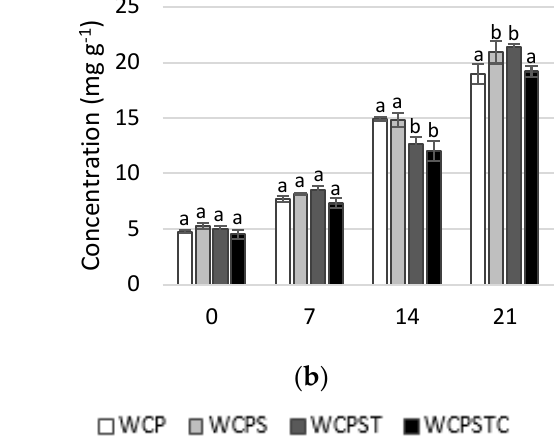
Figure 2. Lactose ( a ) and lactic acid ( b ) concentration of whey cheeses matrices during storage. WCP (control); WCPS (with SCWP); WCPST (with SCWP and thyme EO); WCPSTC (with SCWP, thyme EO and sodium citrate). a,b Means within the same day of storage labeled with different superscripts differ significantly ( p < 0.05).